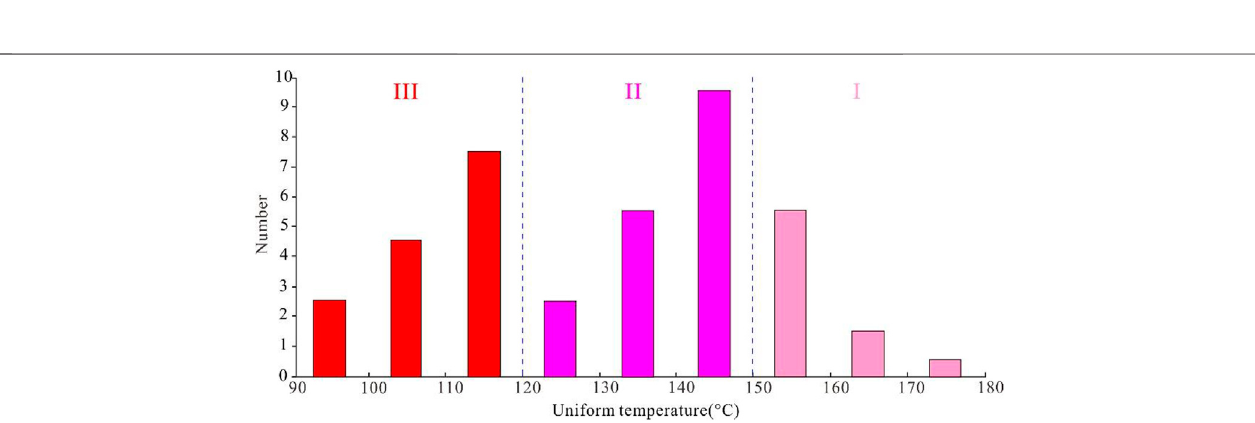
FIGURE 8 | Homogeneous temperature distribution of fl uid inclusions in fracture fi llings of the Luzhou block.